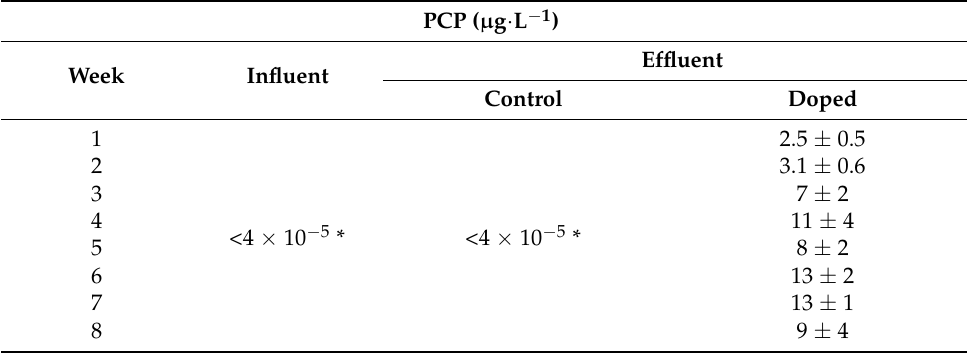
Table 2. Concentration of pentachlorophenol (PCP) ( µ g · L − 1 ) in influent and effluent CWs (mean and standard deviation, n = 3), irrigated for eight weeks with Ribeira de Joane water not doped (control) or doped with 100 µ g · L − 1 PCP per week. * PCP concentration below the detection limit (LOD = 4 × 10 − 5 µ g · L − 1 ) when not